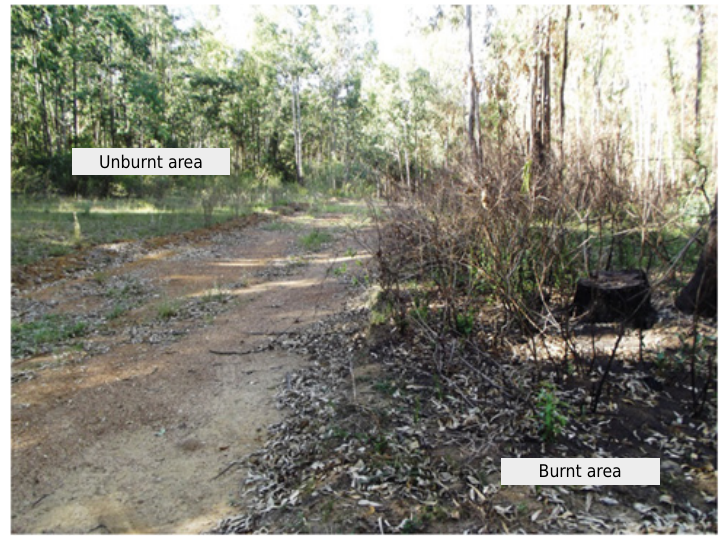
Figure 2. Overview of the eucalyptus forest, of the burnt area (AWF), and of the unburnt area (EF) in São Gabriel, RS,